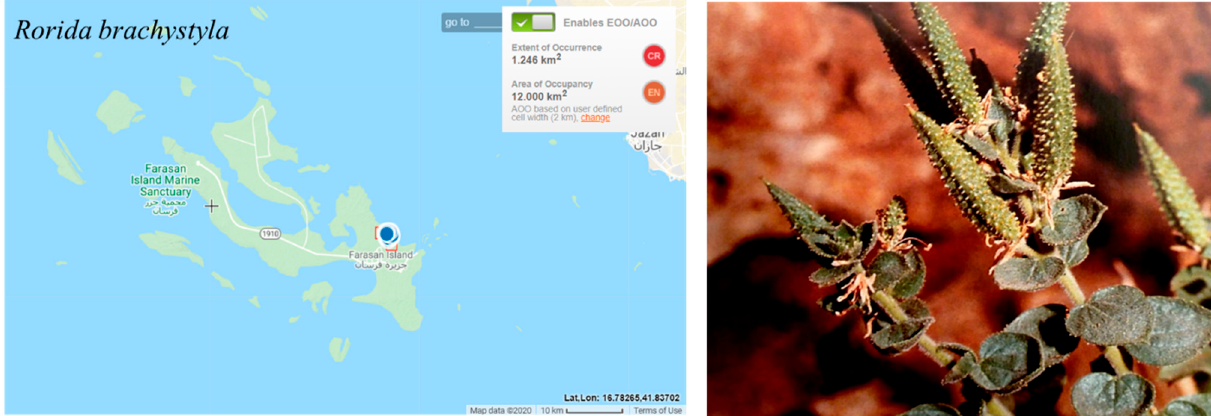
Figure 13. Geographical distribution of Rorida brachystyla in the Farasan Archipelago. Plant photo reproduced with permission from Collenette [7] .